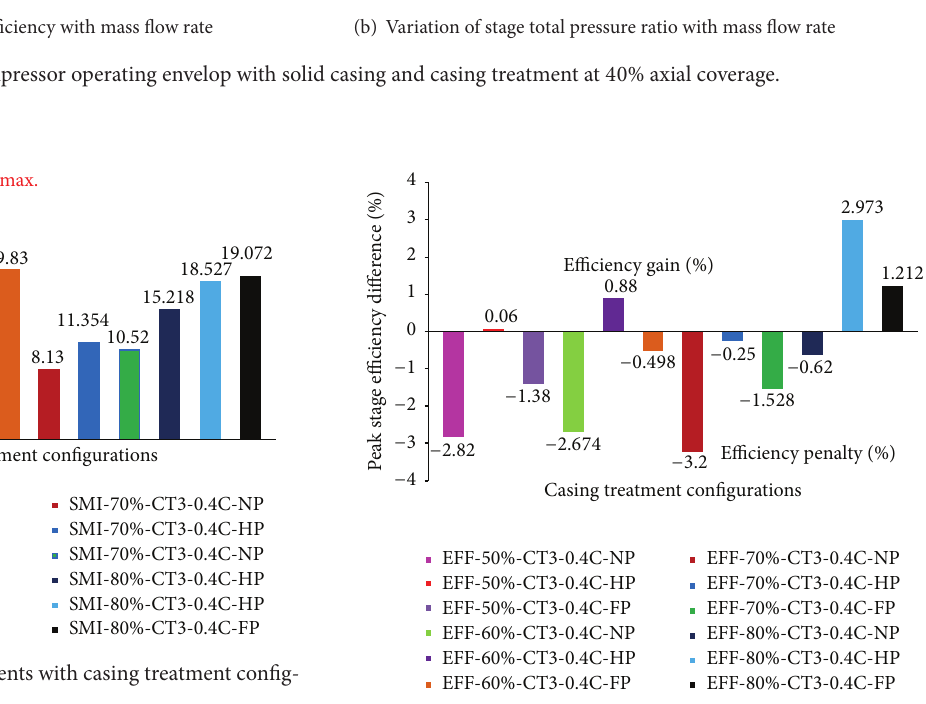
Figure 9: Variation of the peak stage efficiency with casing treat- ment configurations at 40% axial